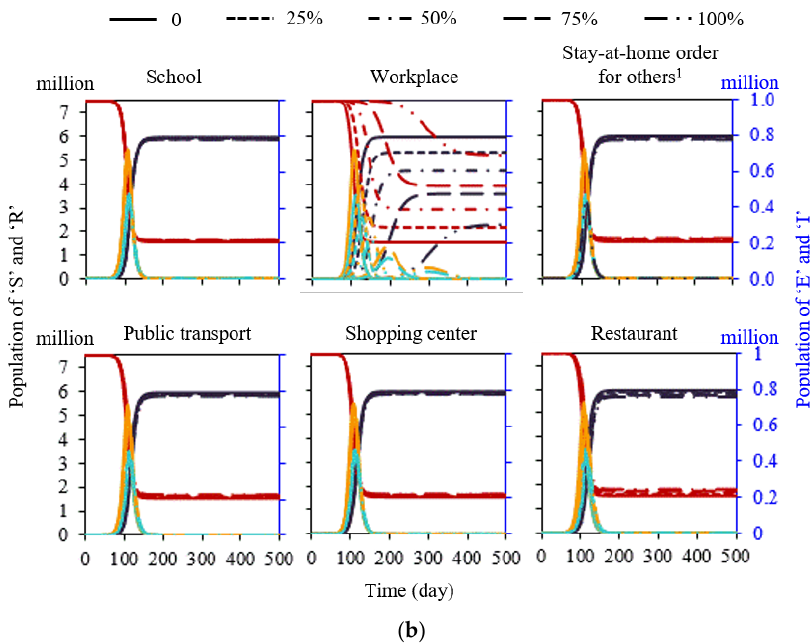
Figure 2. Efficiency of typical built environment closure-related interventions. ( a ) Implementation time (proportion was assumed to be 100%). ( b ) Implementation intensity (interventions were assumed to be implemented on the 31th day after the first confirmed case). 1 Non-workers/non-students.